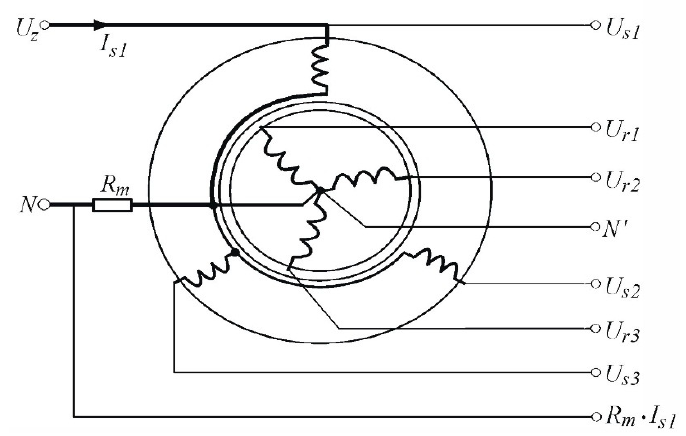
Figure 1. The diagram of connections for one powered winding of the stator.